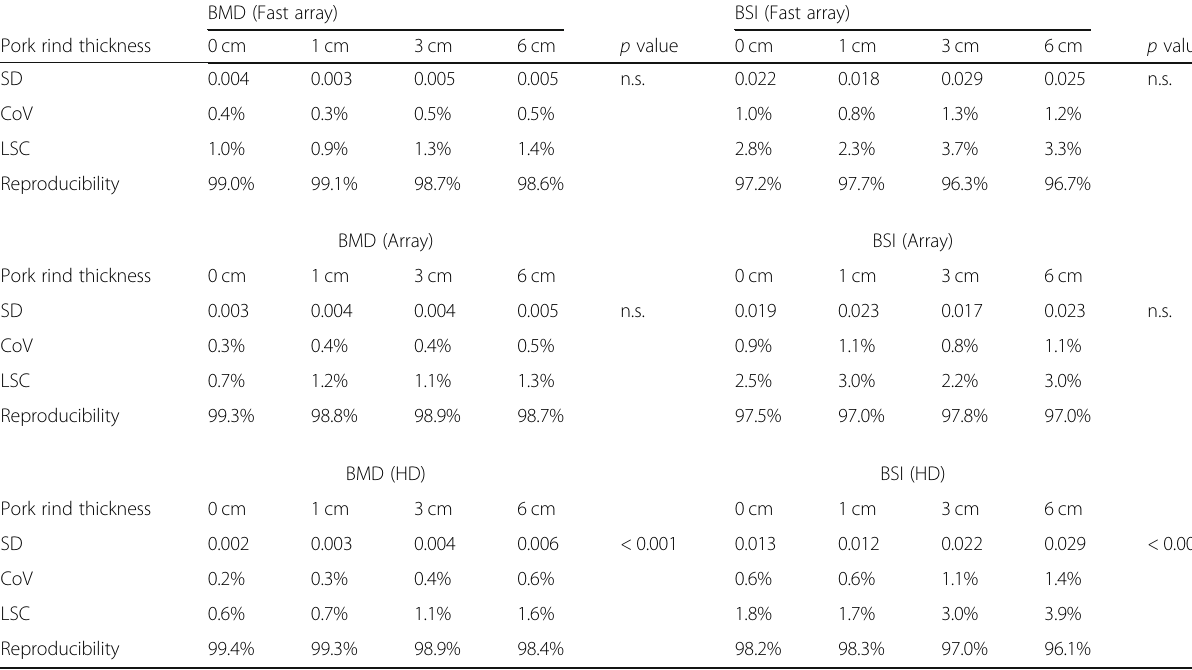
Table 2 Comparison between BMD and BSI reproducibility at different thicknesses BMD (Fast array)